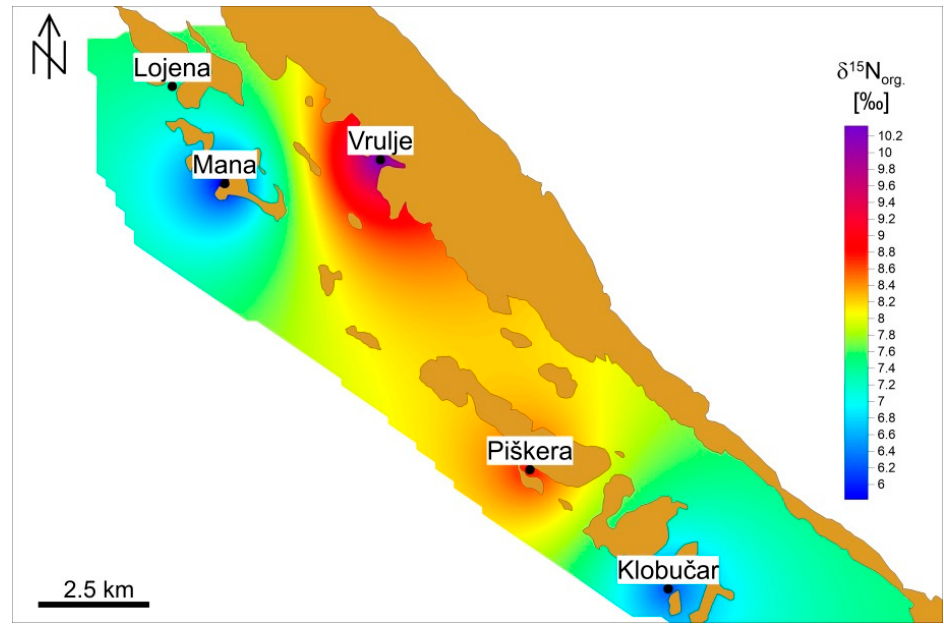
Figure 5. Distribution map of the δ 15 N values of H. trunculus .